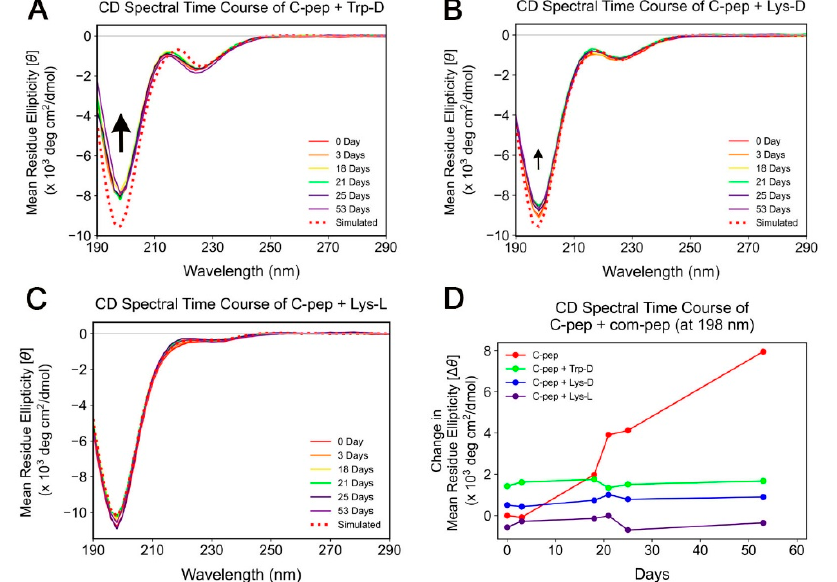
Figure 8. CD spectral time course of unaggregated C-peptide co-assembled with ( A ) Trp-D, ( B ) Lys-D, and ( C ) Lys-L respectively. The relative sizes of the vertical arrows denote the relative change in ellipticity at 198 nm. Panel ( D ) illustrates the change in the mean residue ellipticity at 198 nm relative to the simulated spectra of non-interaction between C-peptide and the 9mer com-peptides; the line due to C-peptide reflects changes relative to 0 day. It shows that Trp-D interacts to the greatest extent with C-peptide, followed by Lys-D and (minimally) Lys-L. It also shows how the electrolyte-like 9mer com-peptides stopped the aggregation of C-peptide.